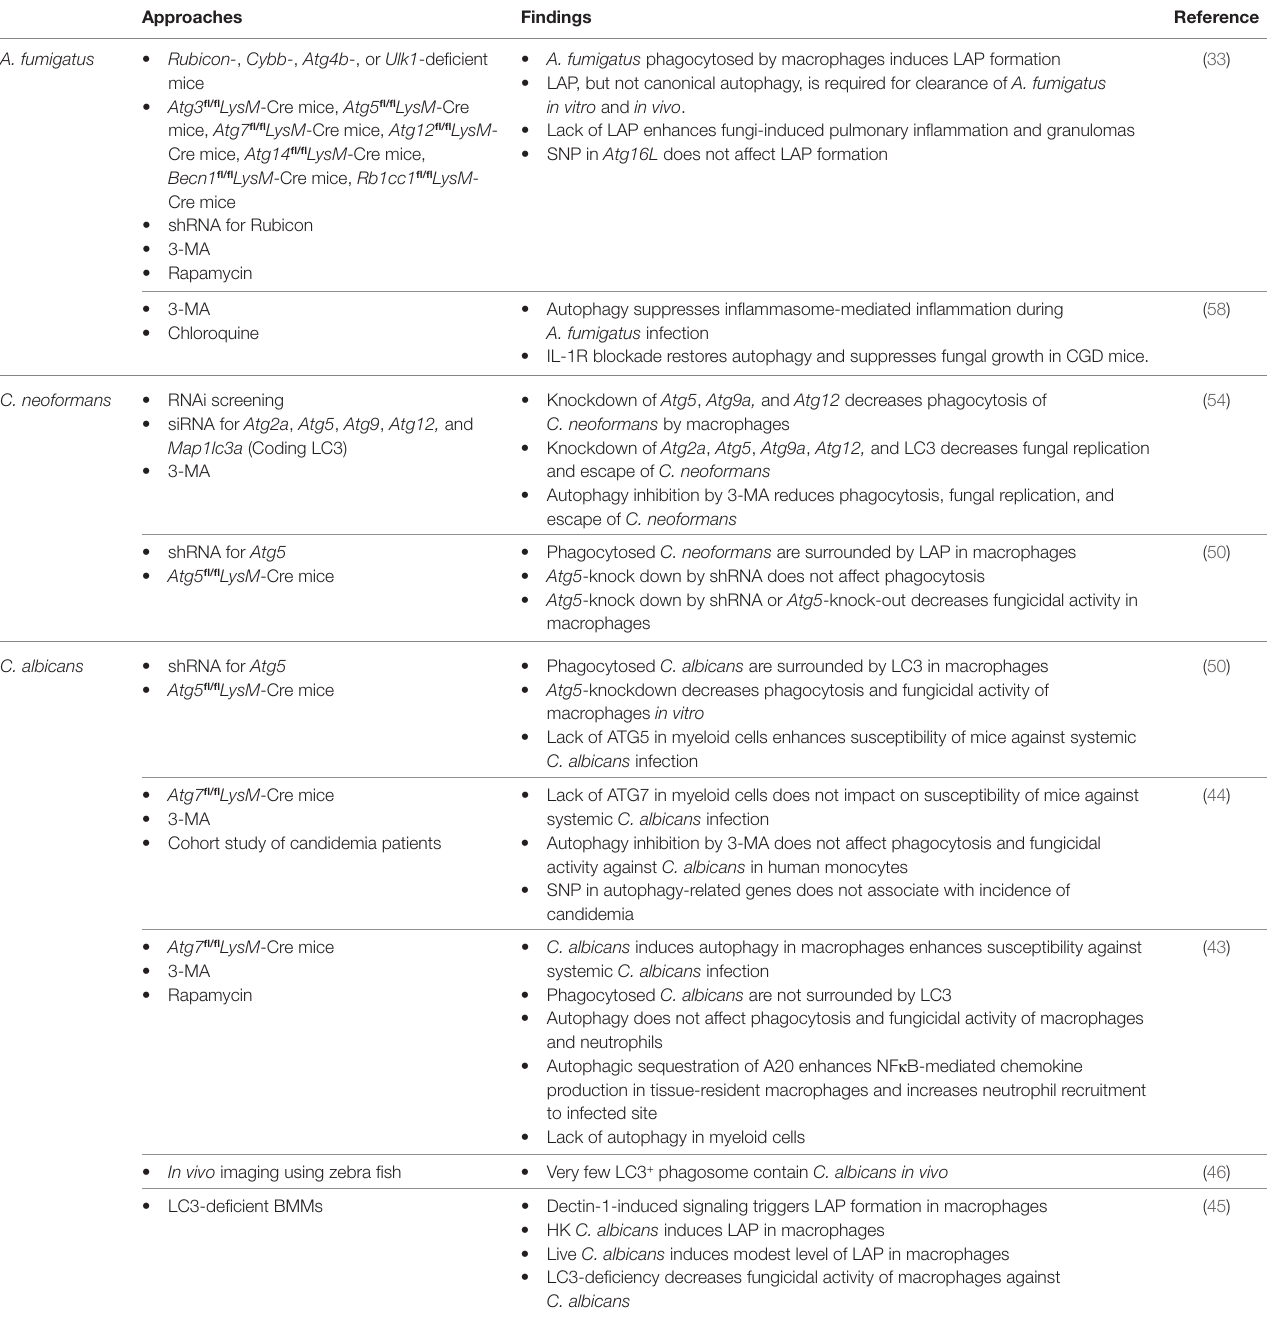
TABLe 1 | impacts of autophagy and LAP on antifungal